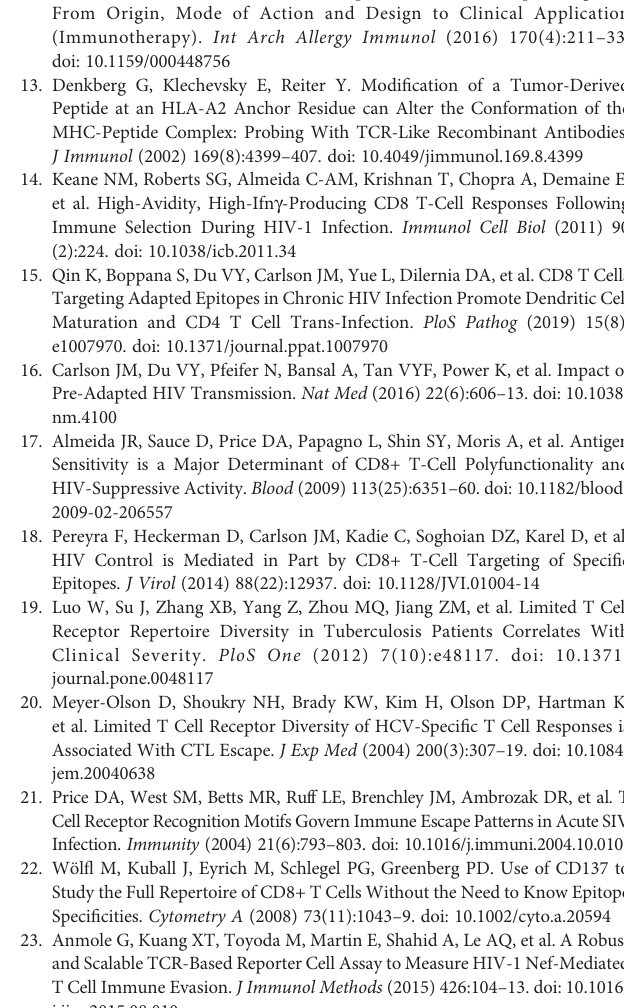
Supplementary Figure 5 | CITE-seq analysis of un-activated cells. Protein expression (A) versus transcript (B) . The initial panel displays clustering of the cells. The most distinct lack of concordance between protein and RNA expression is observed for CD4. The remaining protein and RNA expression are similar, allowing RNA expression levels to inform protein expression. Supplementary Figure 6 | Examplerepresentation of fl ow gating for sorting by tetramersor activation markers(peptide stimulation) andcellsubtype determination. (A) Gating strategyfor TL10 tetramer sorting for subject1. (B) Gatingstrategy for activationmarkersafterTL10NAEpeptidestimulationforsubjectC2.Gatingstrategies arethe same for all subjects.T cell subtype determination was the same regardless of sorting strategy and were based on CD45RO and CCR7 expression. Supplementary Figure 7 | CDR3 overlap within a subject re fl ecting cross- reactive NAE- and AE-speci fi c CD8 + T cells. All productive CDR3s were compared between sample plates to identify possible public clonotypes and/or contamination. Overlaps were predominantly restricted to between conditions within a subject (denoted with thick black boxes), however there was evidence of a likely public clonotypeforthe RF10epitope. Aspeci fi cTCR alphaandbeta pairwasfoundinthe chronic (C4) and acute (A1) subject that is likely to be a public clonotype. Note the alpha chain paired with other beta chains in each of the two subjects but these combinations were subject-speci fi c. N =